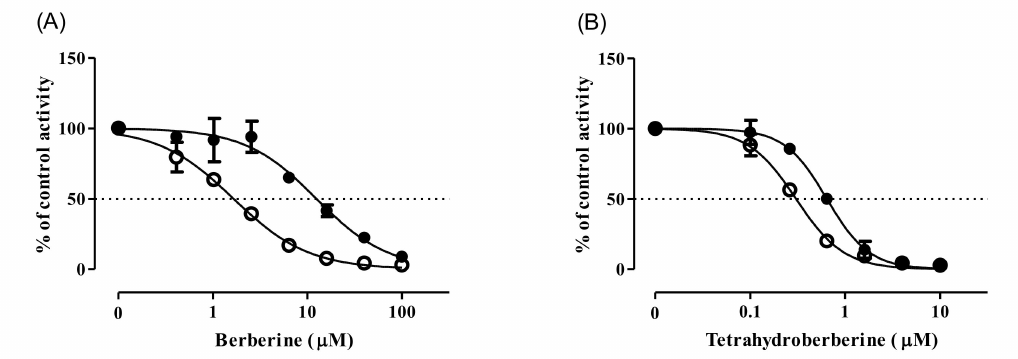
Figure 1. E ff ects of berberine and tetrahydroberberine on CYP1A2 ( A ), CYP2A6 ( B ), CYP2B6 ( C ), CYP2C8 ( D ), CYP2C9 ( E ), CYP2C19 ( F ), CYP2D6 ( G ), CYP2E1 ( H ), CYP3A4 (( I ), MDZ), and CYP3A4 (( J ), TST) in pooled HLM. The activity is expressed as the percentage of control samples containing no inhibitor (100%). Data show the mean ± standard deviation (SD) of three separate samples.